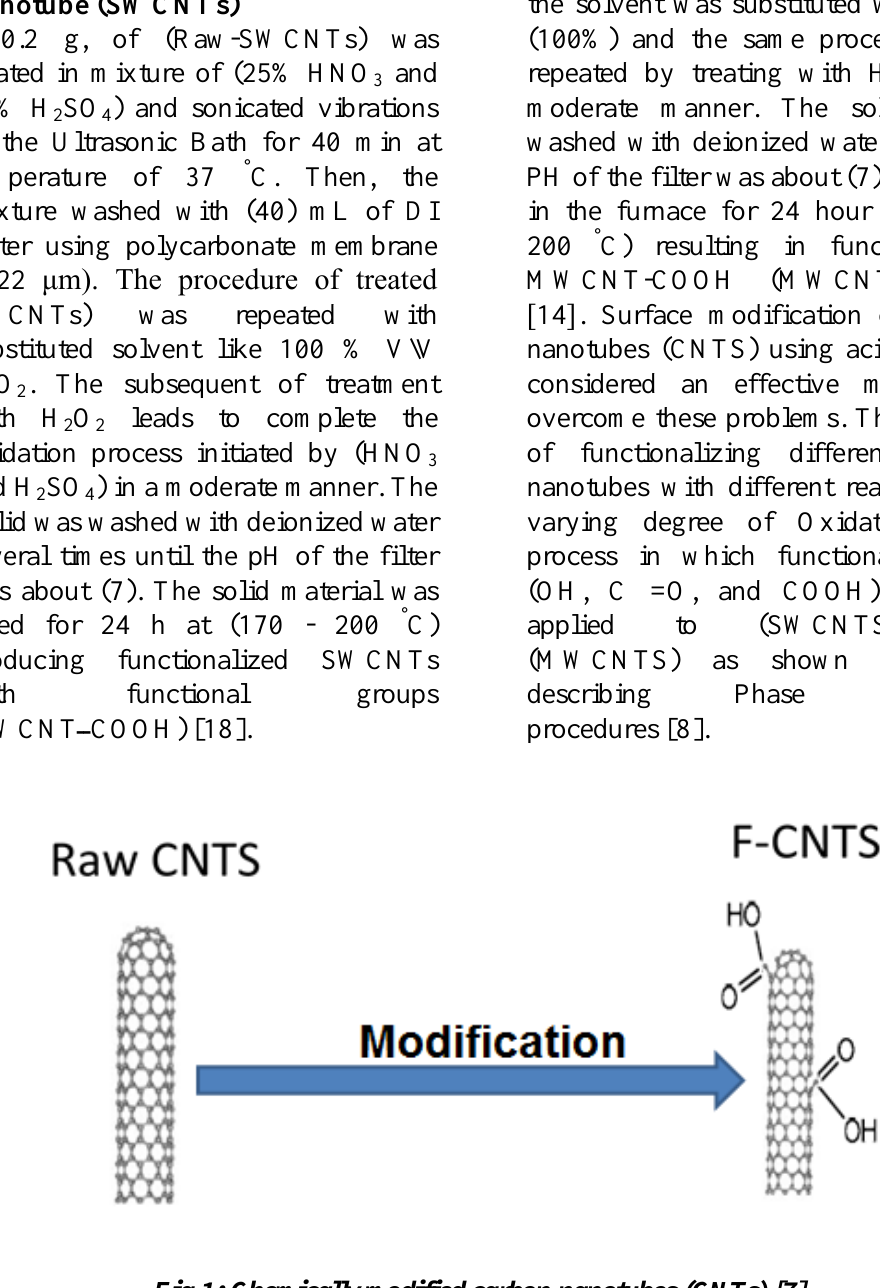
Fig.1: Chemically modified carbon nanotubes (CNTs)